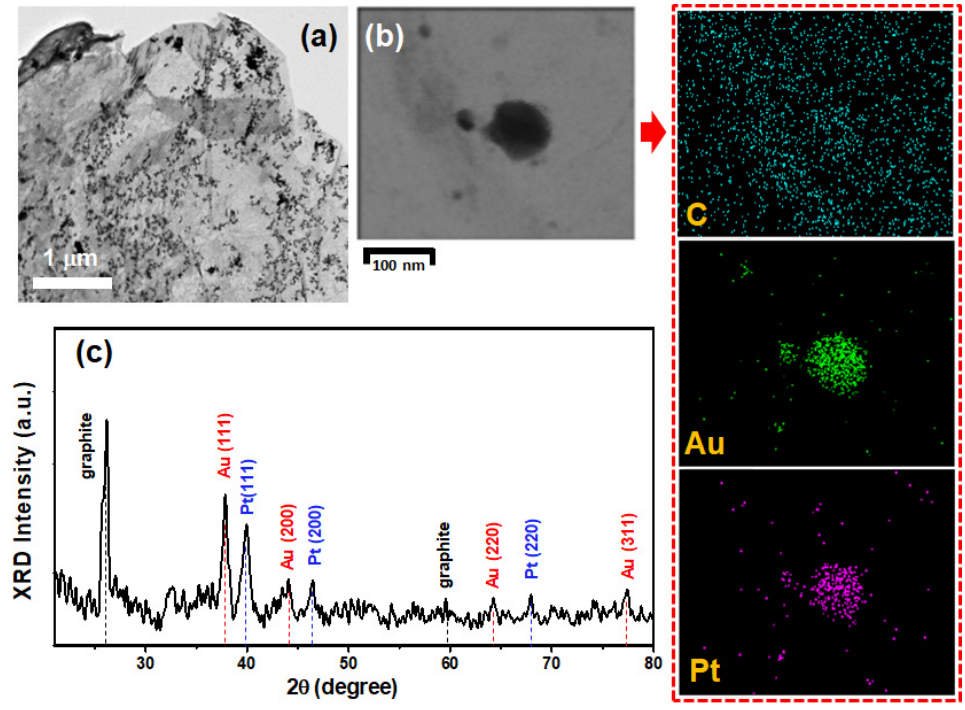
Table 1. ICP-MS results of TG/Au x Pt y catalysts. V Au and V Pt are the adding volumes of HAuCl 4 and H 2 PtCl 6 precursor solutions, respectively.